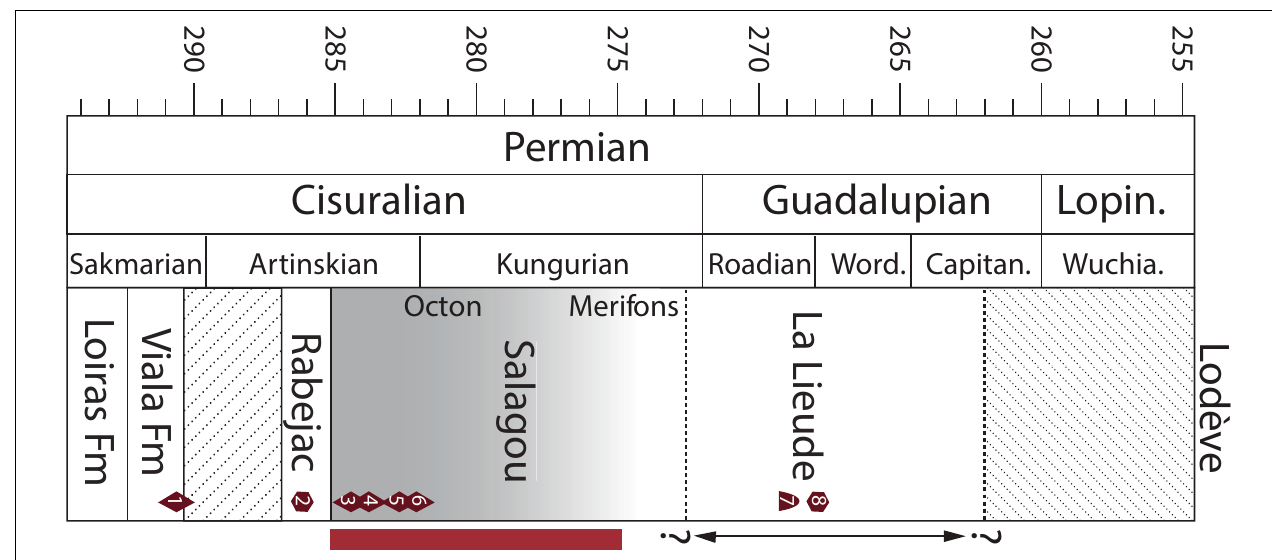
FIGURE 2 | A summary of the current Permian chronostratigraphic constraints of the Salagou Formation (Lodève Basin). The section where MS data were measured in this study is highlighted in gray and also indicated with the red bar. Note that the upper age of the Salagou Formation is very poorly constrained. Icon shapes indicate different types of age data, numbered 1–8 according to the sources from which they are derived; Specifically: (1) U/Pb ID-TIMS on ash 291.0 ± 0.2 from the upper Viala Formation (Michel et al., 2015), (2) tetrapod tracks, Dromopus–Erpetopus biochron boundary, ∼ 290–284 Ma (Schneider, pers. commun. 2020 ); (3–6) U/Pb ID-TIMS on ash (in stratigraphic order: 284.4 ± 0.1, 284.5 ± 0.1, 283.5 ± 0.1, 282.9 ± 0.1) from the Octon Member of the Salagou Formation (Michel et al., 2015), (7) magnetostratigraphic data from the La Lieude Formation that suggests proximity to the end of the “Kiaman” or Permo-Carboniferous Reversed Superchron (PCRS), ca. 262 Ma (Evans, 2012), and (8) tetrapod track ichnofauna from the La Lieude Formation consistent with a Guadalupian age (Schneider et al., 2010, 2019).